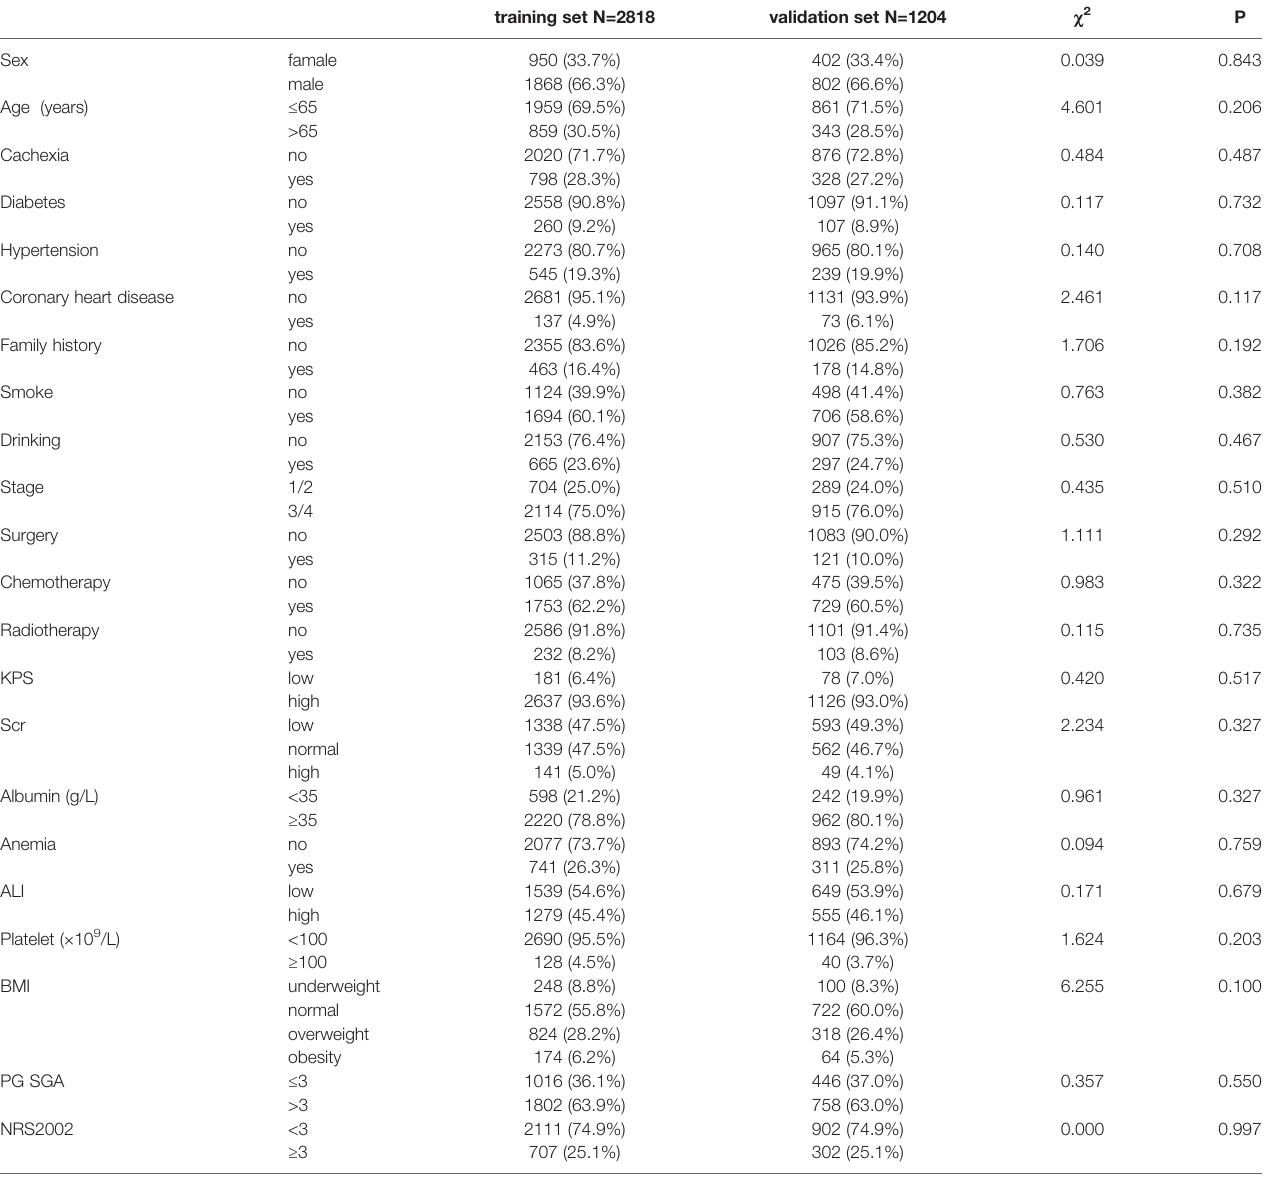
TABLE 1 | Demographic and clinical characteristics of patients diagnosed with lung